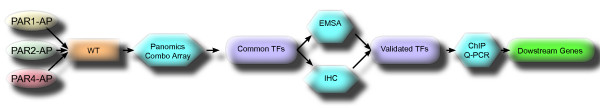
Molecular Approach. A top-down approach was used to determine transcription factors involved in the response of the mouse bladder to pro-inflammatory PAR-APs. This approach started by selecting a candidate TF out of 345 different TF consensus sequences present in a protein/DNA combo array (Panomics). Next, PAR-induced alteration in this TF binding was validated by EMSA and IHC was used to confirm its expression in the urinary bladder. Finally, an antibody recognizing this TF was used for CHIP/Q-PCR assay and revealed up-regulation of downstream genes.